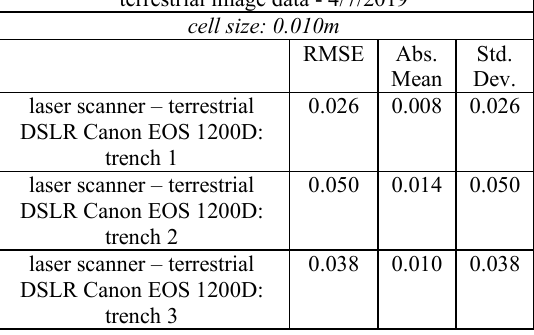
Table 6 . 3D model comparison between laser scanner and terrestrial image data of the first day of the